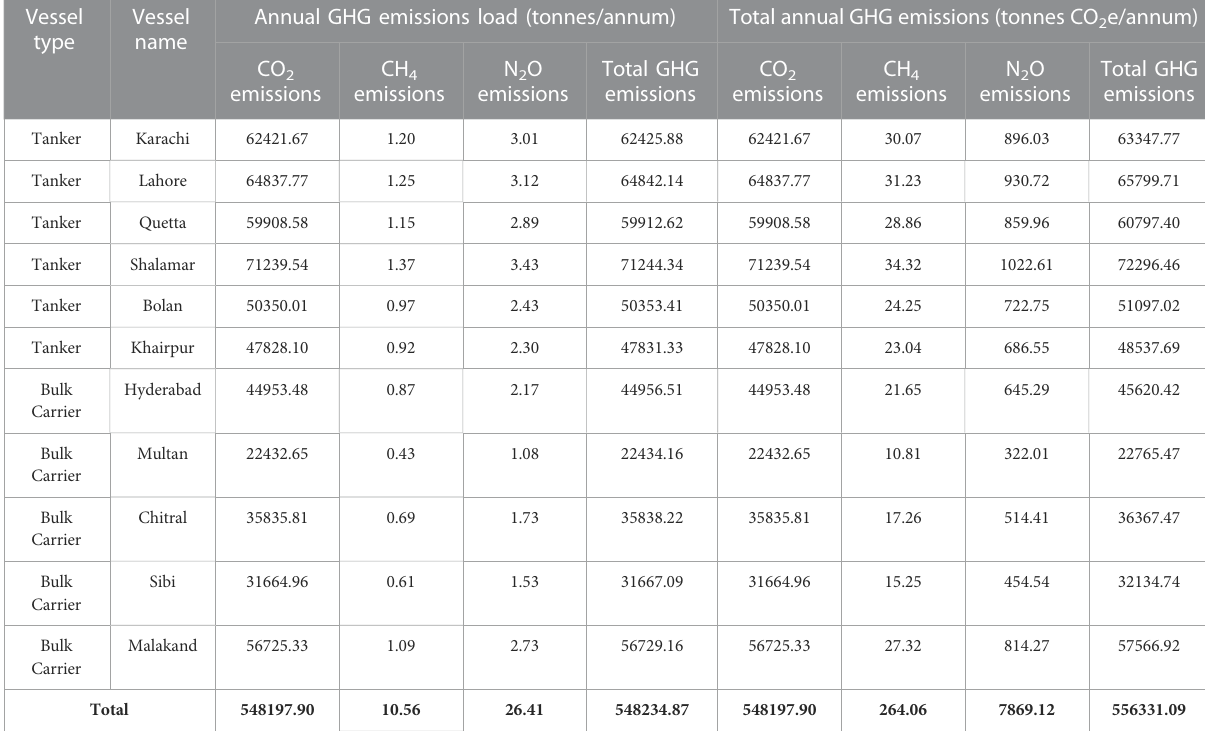
TABLE 9 Breakdown of total GHG Emissions from PNSC ’ s fl eet based on fuel consumption of VLSFO. Vessel